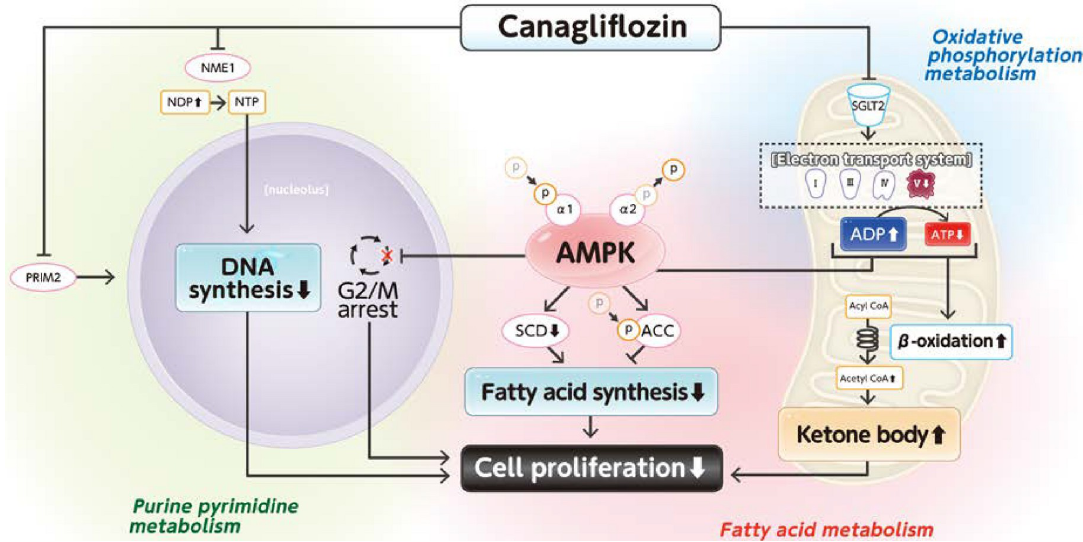
Fig 7. A scheme for proposed mechanisms for canagliflozin-induced suppression of cell proliferation in Hep3B cell. Abbreviations: SGLT2, sodium-glucose cotransporter 2; ADP, adenosine diphosphate; ATP, adenosine triphosphate; AMPK, AMP-activated protein kinase; SCD, stearoyl-CoA desaturase; ACC, acetyl-CoA carboxylase; NME1, nucleoside diphosphate kinase1; NDP, nucleotide diphosphate; NTP, nucleotide triphosphate; PRIM2, DNA primase, polypeptide 2; DNA, deoxyribonucleic acid.